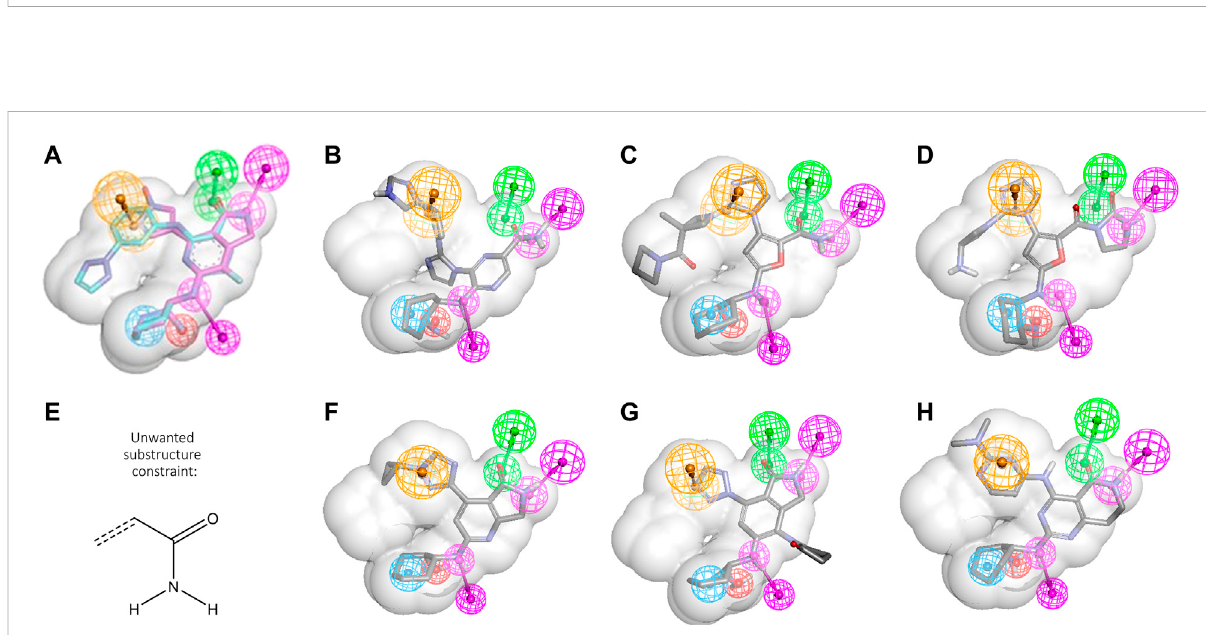
FIGURE 3 Scaffold hopping using PRT-062607 and mivavotinib. (A) PRT-062607 and mivavotinib alignment using PDBid 4rxp and 5tr6, respectively. Six common features are depicted (HBD magenta, HBA green, hydrophobe cyan, ring aromatic orange, negative charge red, for more detail see in portola_6FeaSHPSI). (B – D) Representative GTD results aligned to PH4. (E) Unwanted substructure fi lter. (F) Closest GTDresult to mivavotinib. (G,H) Representative GTD results with cyclized carboxamide grouping.